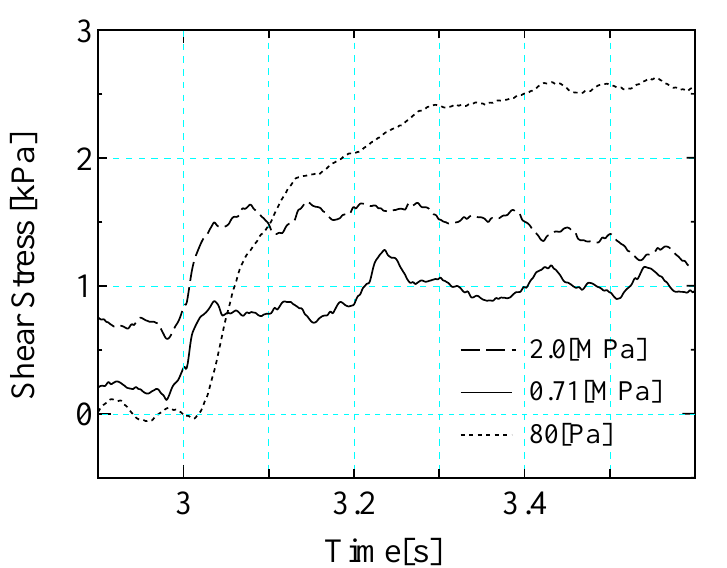
Figure 5. Testbed for an EA gel clutch.